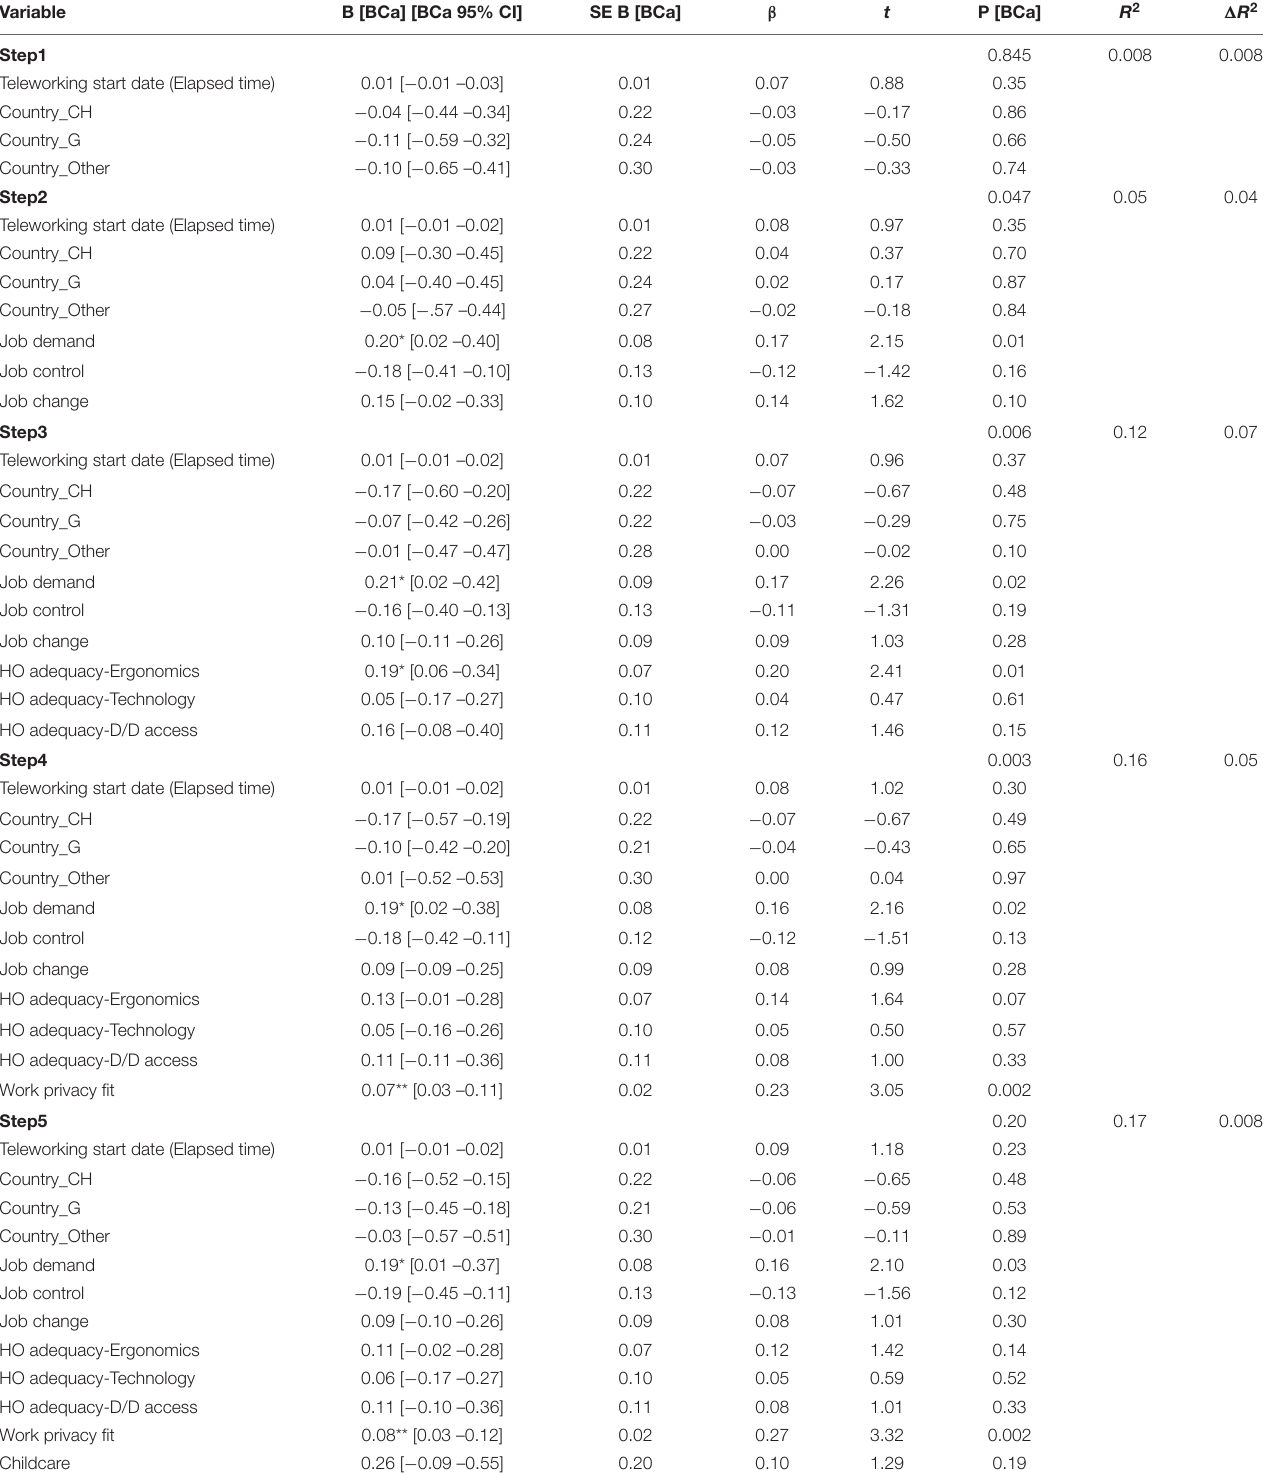
TABLE 3 | Hierarchical regression model of job-related factors, environmental factors, social factors, and perceived productivity on FTI.